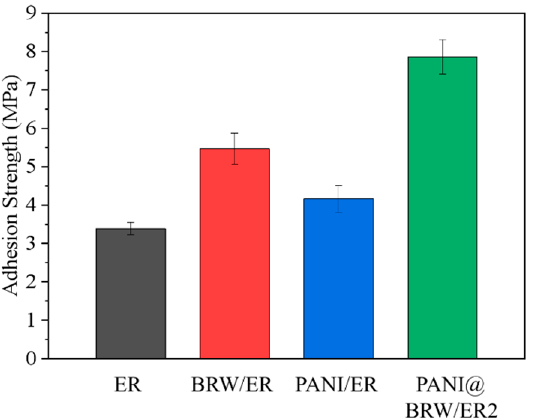
Figure 12. Adhesion strength results of ER, BRW/ER, PANI/ER, and PANI@BRW/ER2 coatings (the error bars show the standard error of the mean obtained from five repeated tests.